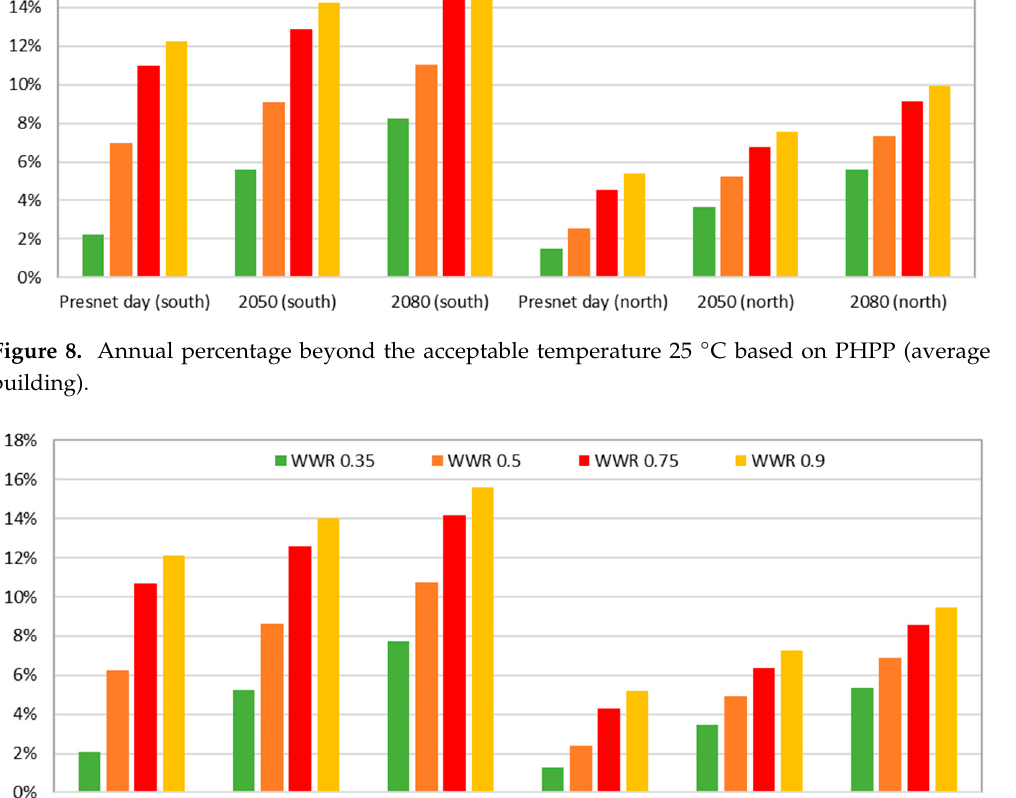
Figure 8. Annual percentage beyond the acceptable temperature 25 °C based on PHPP (average building).